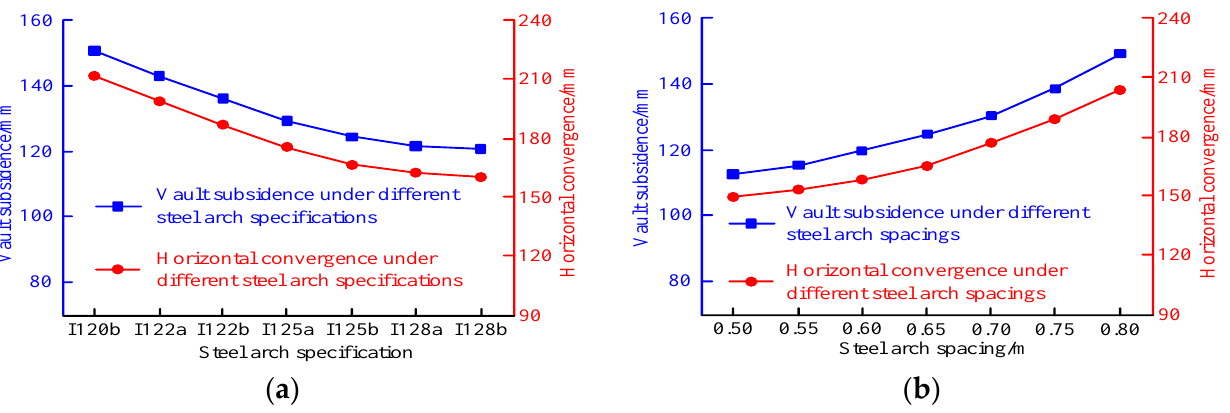
Figure 7. ( a ) Tunnel deformation curves under different steel arch specifications and ( b ) tunnel deformation curves under different steel arch spacings. Tunnel deformation curves under different steel arch frame parameters.